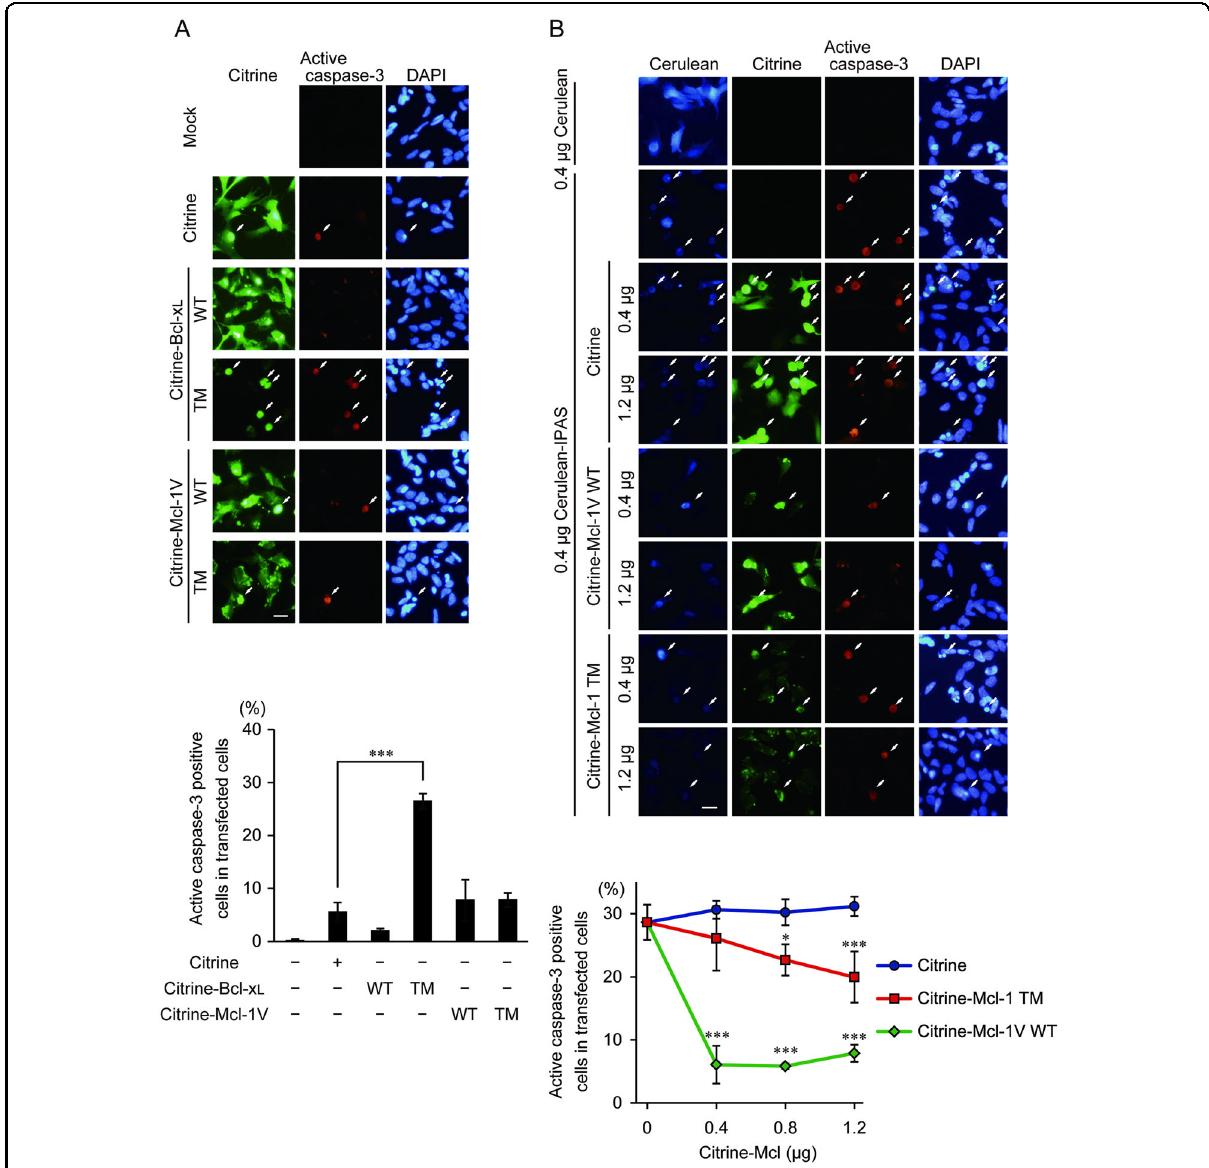
Fig. 2 Suppression of IPAS-induced apoptosis by coexpression of Mcl-1 TM. A Cell toxicity of Bcl-x L TM peptide. SH-SY5Y cells in a 12-well plate were transfected with 1.6 μ g pCitrine-C1, pCitrine-Bcl-x L WT, TM, pCitrine-Mcl-1 WT, or TM, and fi xed 24 h after transfection. Apoptotic cells were stained by antibody against active caspase-3. Active caspase-3-positive cells were indicated by the arrows. Scale bar, 20 μ m. The bar graph below represents the percentage of active caspase-3 positive cells detected by the observation of at least 300 transfected cells (mean ± SD of three independent experiments). *** p < 0.001. B Decrease in Cerulean-IPAS induced cell death by the expression of Citrine-Mcl-1V WT or Mcl-1TM. SH-SY5Y cells in a 12-well plate were cotransfected with 0.4 μ g of pCerulean-C1 or pCerulean-IPAS and 0.4 – 1.2 μ g of pCitrine-C1, pCitrine-Mcl-1V WT, or pCitrine-Mcl-1 TM. Apoptotic cells were analyzed as in A . Scale bar, 20 μ m. The line graph below represents the percentage of active caspase-3 positive cells detected by the observation of at least 300 transfected cells (mean± SD of four independent experiments). * p < 0.05, *** p <